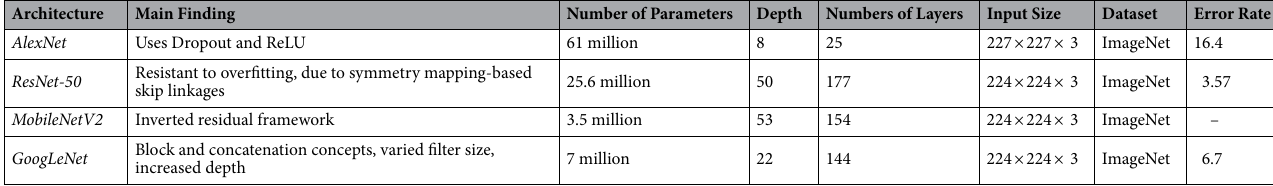
Table 2. Brief overview of the pre-trained CNN architectures.